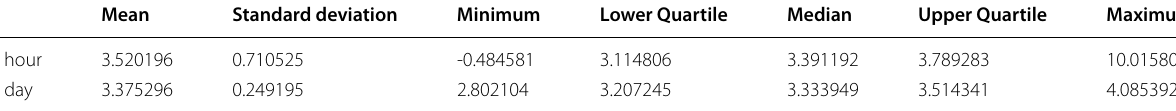
Table 1 Common statistics of layer actions response time under different sampling granularities Mean Standard deviation Minimum Lower Quartile